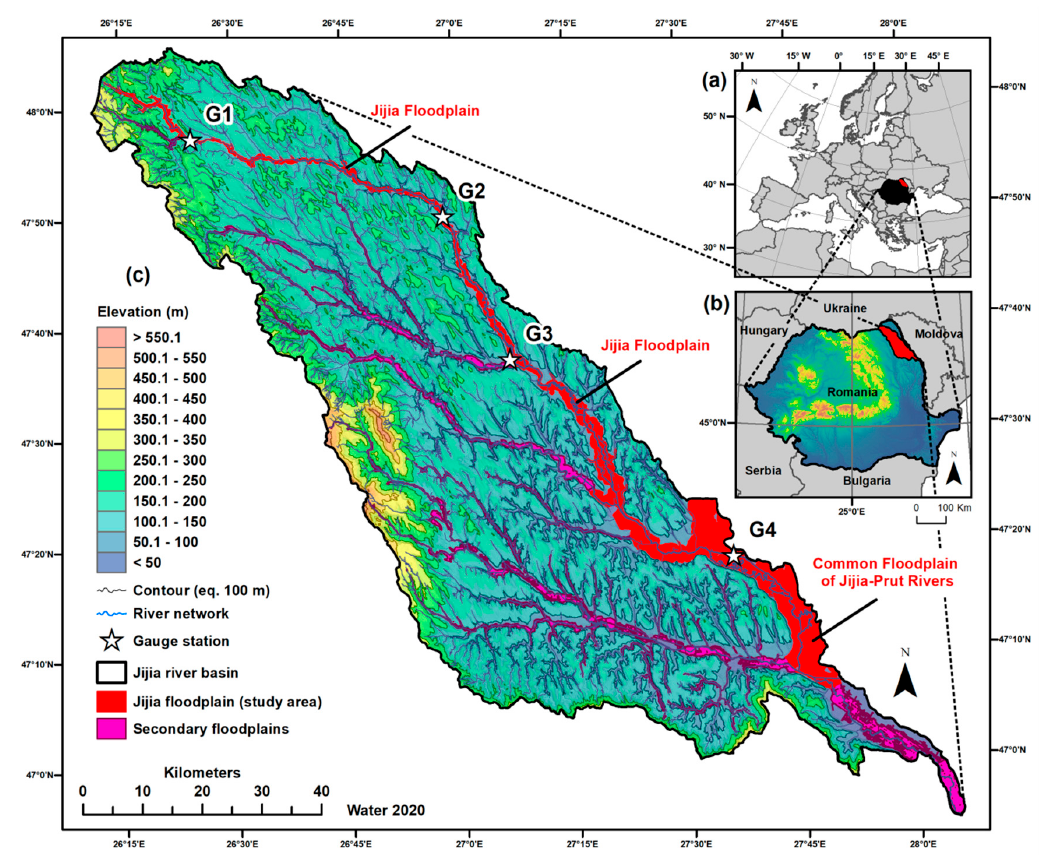
Figure 1. Geographical location of the Jijia river basin in ( a ) eastern Europe and ( b ) north-eastern Romania (Jijia Plain); ( c ) Location of the Jijia floodplain (see Figure 2.) within the Jijia river basin and the gauging stations (G1: Dorohoi; G2: Dangeni; G3: Todireni; G4:Victoria) used for 1D HEC-RAS modeling.